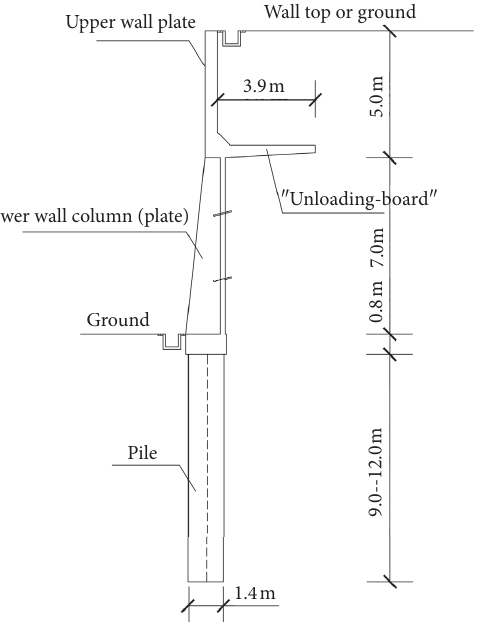
Figure 1: The cross section of the sheet pile wall with a relieving platform in a